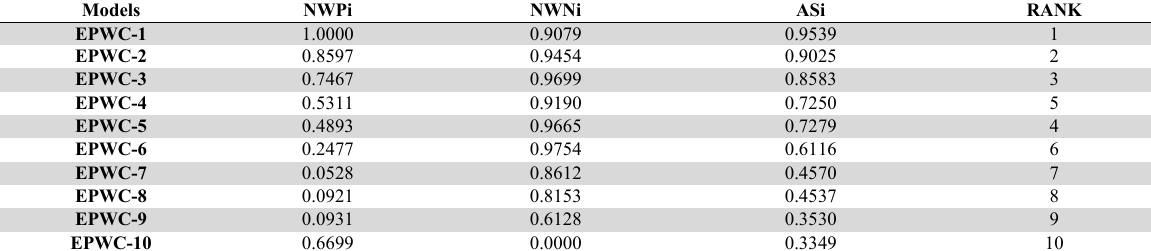
Appraisal score and corresponding Rank